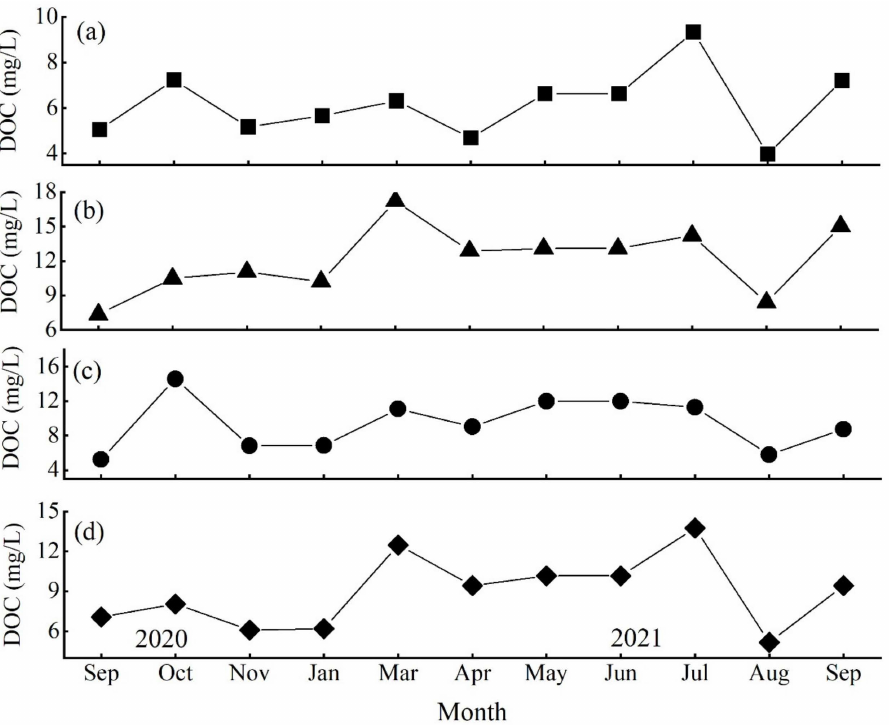
Figure 2. Monthly variations of DOC concentration in the natural pond ( a ), sewage pond ( b ), aquaculture pond ( c ), and irrigation pond ( d